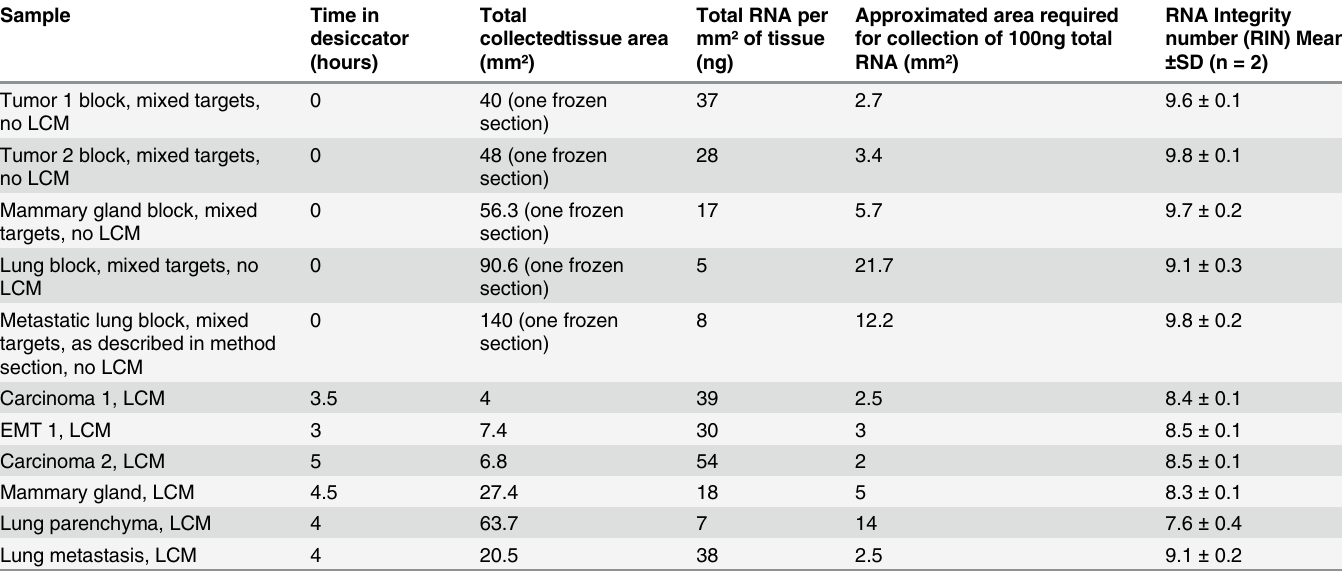
Table 2. Evaluation of Tissue Integrity, LCM Workflow Suitability, Quality and Yield of RNA in LCM